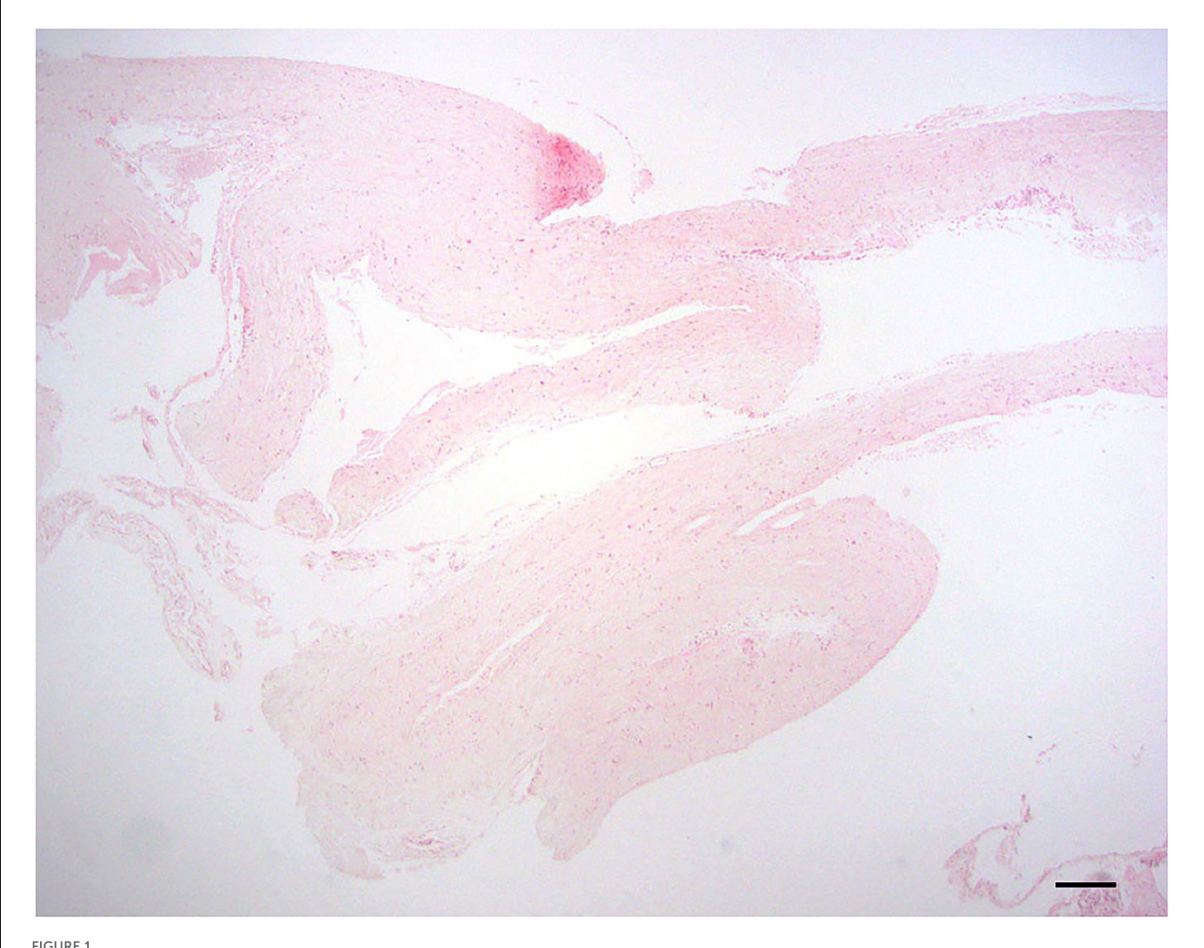
FIGURE1 Normal dura; 10 × –Scale bar = 100